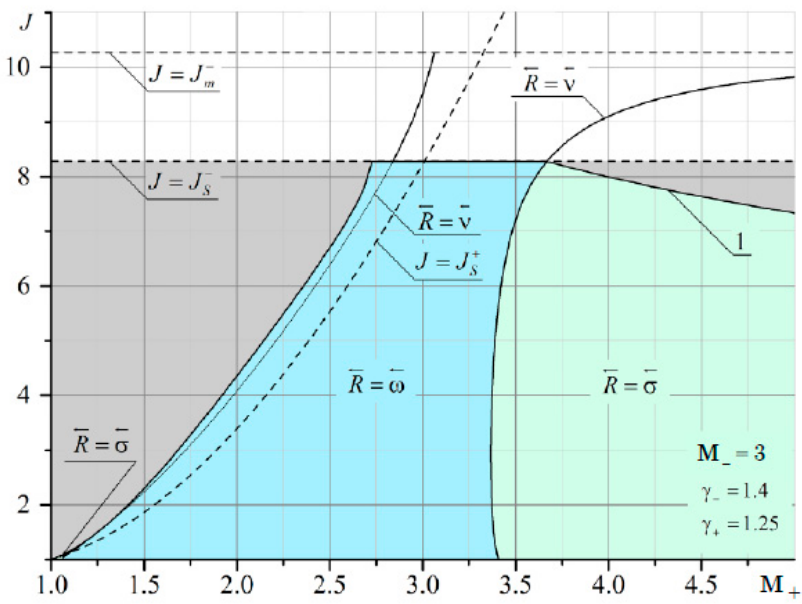
Figure A14. Domains of existence of reflected discontinuities for refraction from a diatomic gas into a gas consisting of combustion products. The Mach number of the flow from which the shock comes is M – = 3. The domains of existence of reflected discontinuities for refraction from a diatomic gas into a gas consisting of combustion products at the Mach number of the flow M – = 5 are shown in Figure A15.